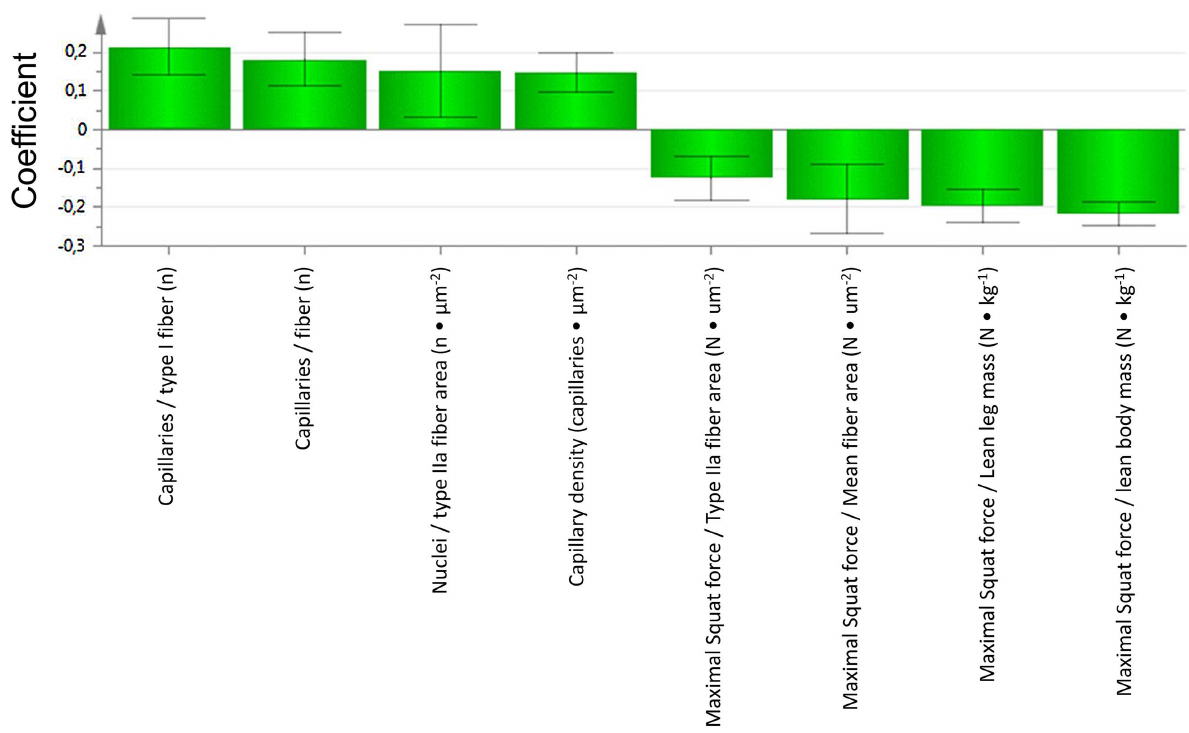
Figure 4. The coefficient plot of variables of importance in the OPLS-DA model. From the OPLS-DA model in Figure 3, the significant important muscle morphological and performance variables separating Doped from Clean subjects are displayed with 95% confidence interval using jack-knifing test. Bars indicate scaled ratios between the Doped and the Clean groups, with higher ratios of the Doped group to the left, and lower ratios to the right.